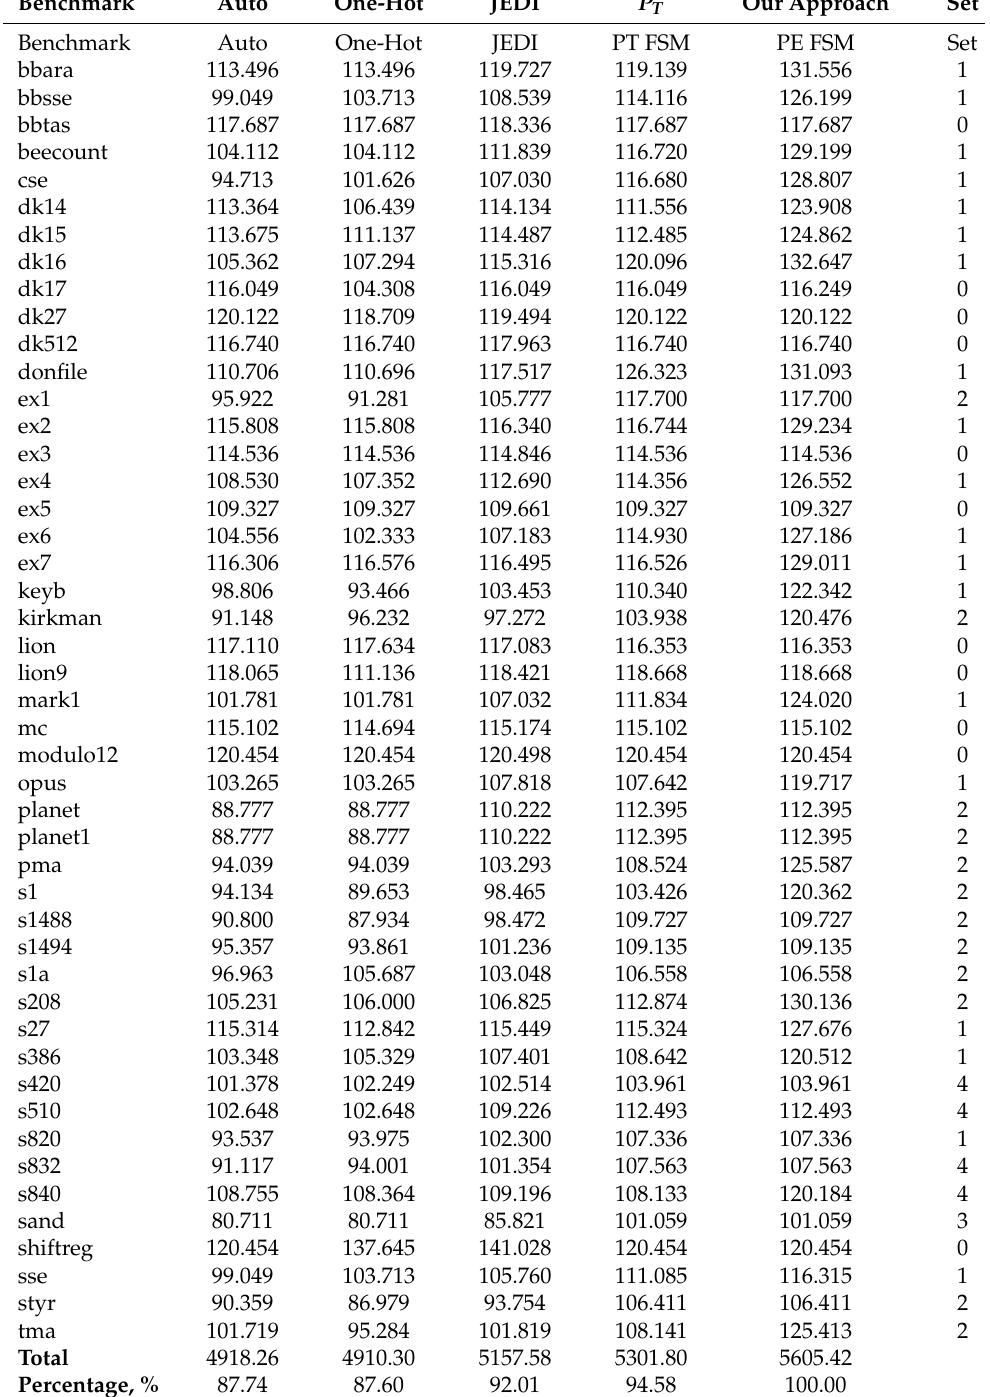
Table 11. Experimental results (the maximum operating frequency,